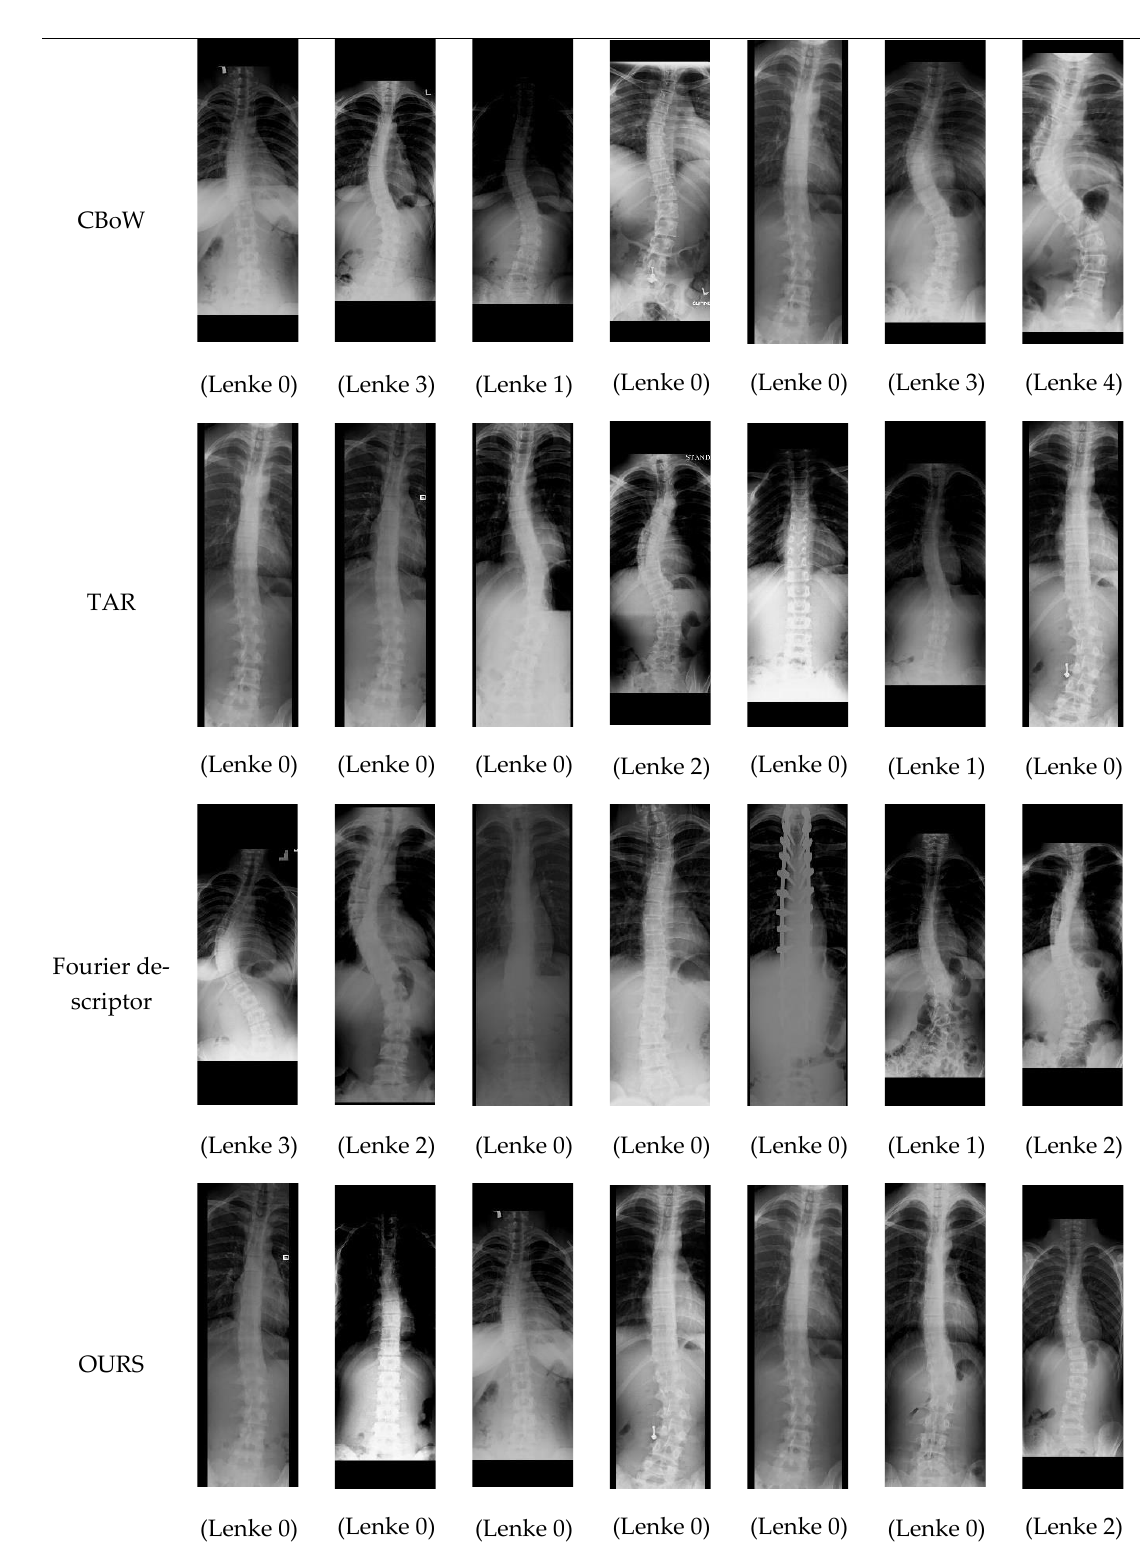
Figure 17. Image retrieval example for different shape descriptors with the query of Lenke 0.